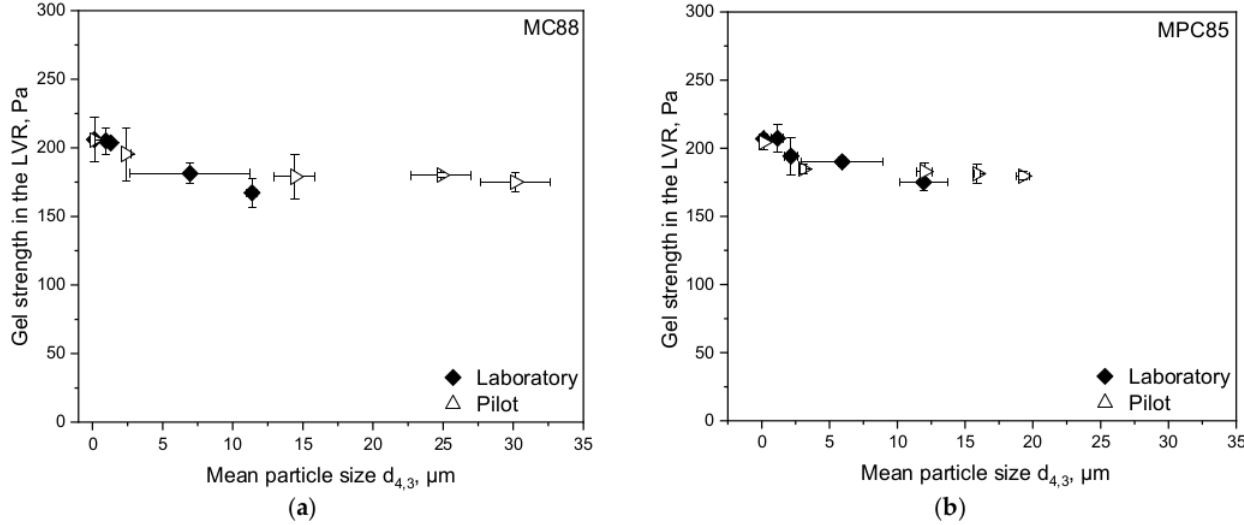
Figure 8. Gel strength in the linear viscoelastic region (LVR) of skim milk enriched with MC88 ( a ) and MPC85 ( b ) produced in laboratory and pilot scale as a function of mean particle size d 4,3 . Particle sizes decrease with increasing shear